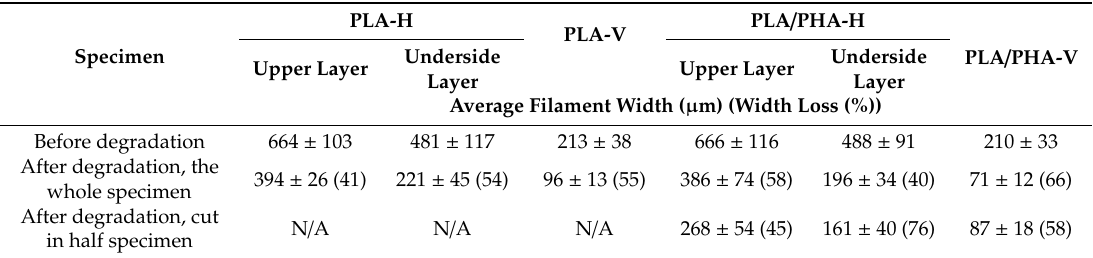
Table 1. Average filament width of the upper (UH) and underside (BH) layers of PLA and PLA / PHA dumbbell-shaped specimens obtained by 3D printing in horizontal (H) and vertical (V) directions before and after 70 days of hydrolytic degradation test at 70 ◦